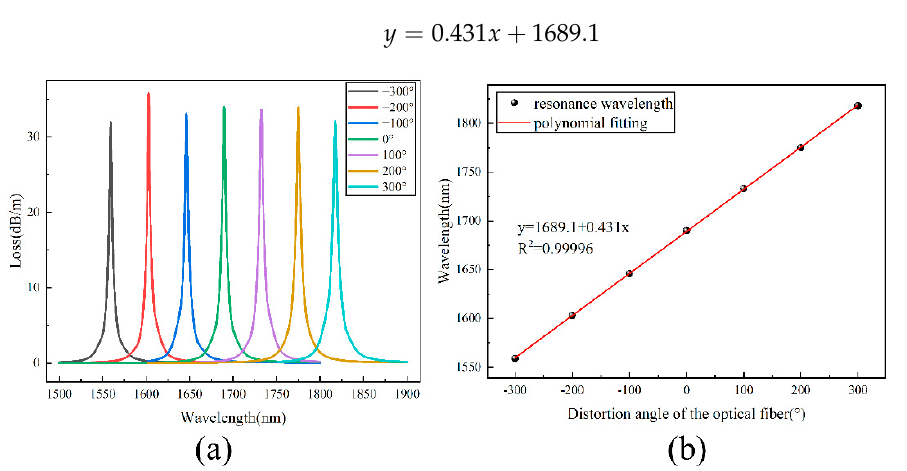
Figure 7. ( a ) Loss spectra of HMSF with different additional torpor; ( b ) fitting relation between the